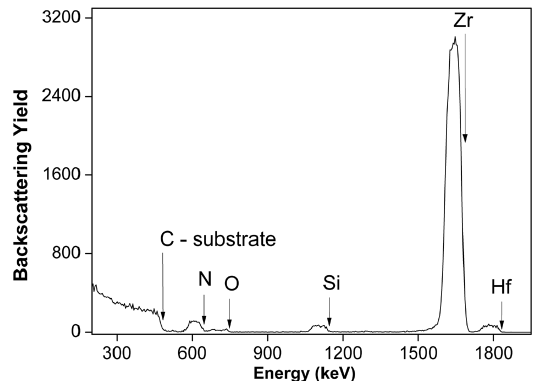
Figure 1. RBS analysis for sample ZrSiN_3. Coatings compositions are almost